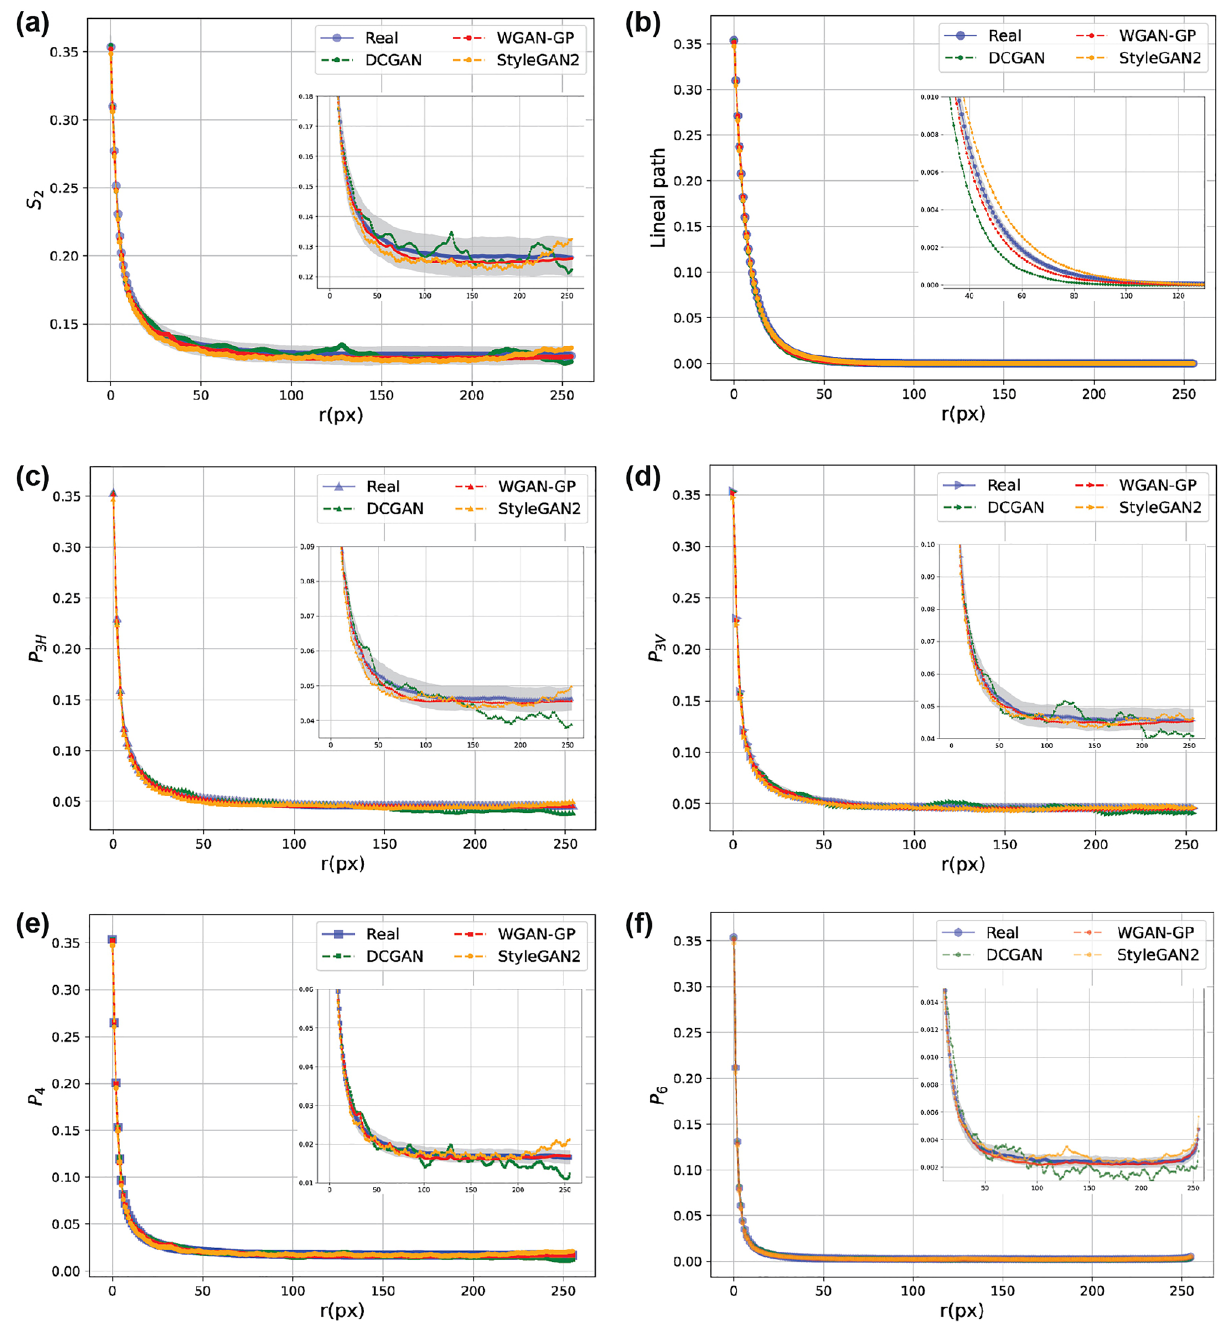
Figure 10. Characterising original and reconstructed serpentinite = − microstructures using different GANs. 95 percent confidence levels around the average values of real microstructure are shown by grey